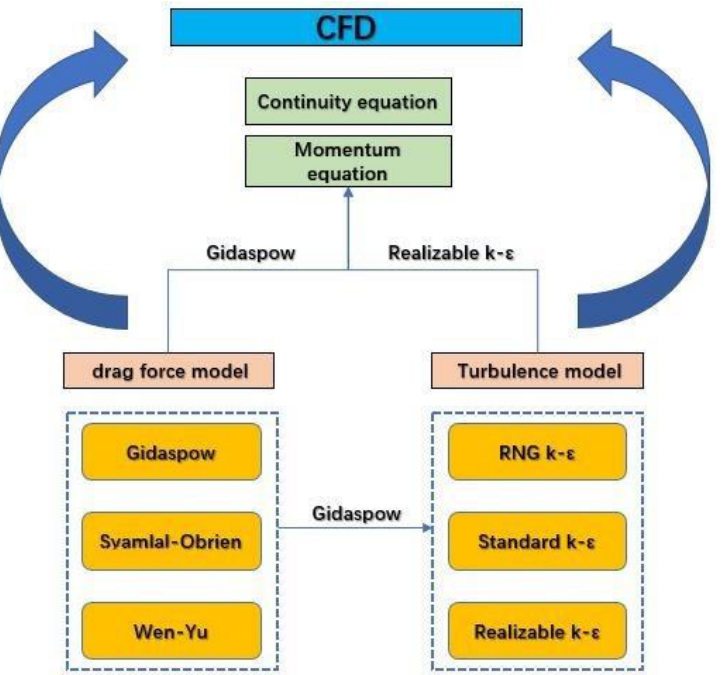
Figure 3. The optimization flow diagram of CFD simulation.